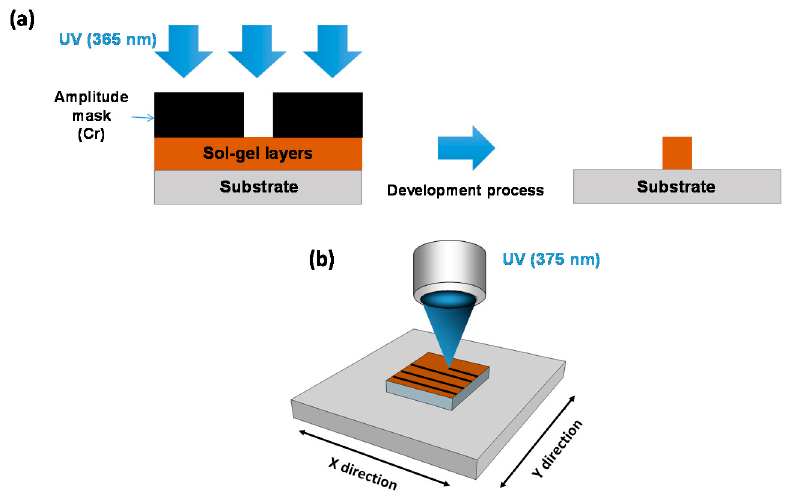
Figure 3. Example of the photolithography processes used for the layer structuration. ( a ) Photolithog- raphy by photomask on an organic–inorganic layer. ( b ) Principle of the direct writing technique (Dilase 750 from Kloé company, Montpellier, France). A laser beam is focused on the hybrid thin films. The structures are created by the translation of the stages in the X and Y directions while the laser beam is fixed. The black lines on the layer represent the UV photopolymerized exposed regions.